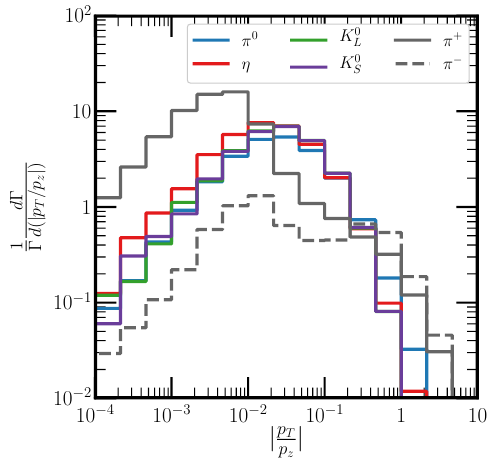
Figure 3 . Identical to the right panel of (cid:12)gure 2, except for unfocused neutral mesons: (cid:25) 0 (blue), (cid:17) (red), K 0 (green), and K 0 (purple). We include the focused/unfocused (cid:25) + / (cid:25) (cid:0) distributions for L S comparison in grey solid/dashed